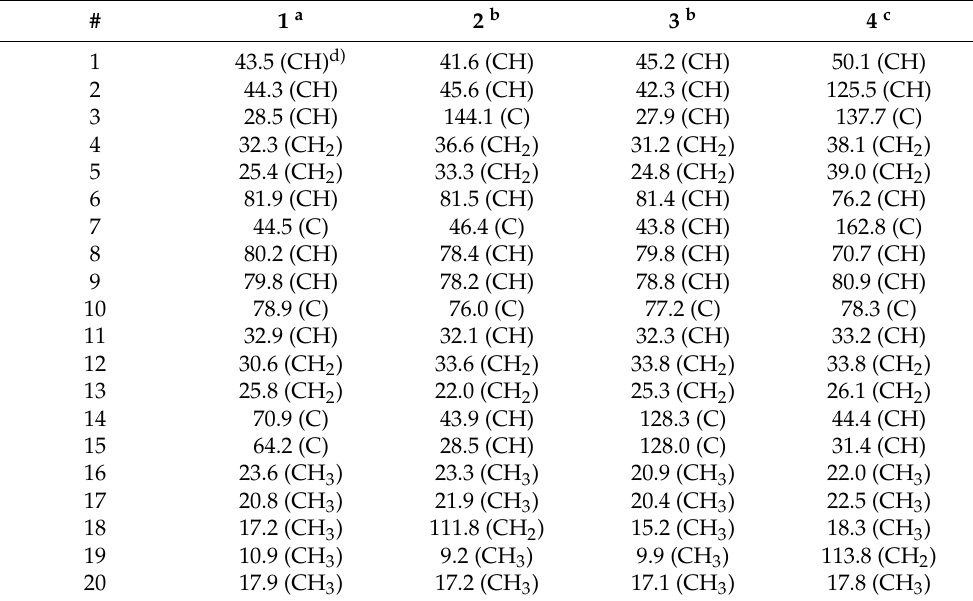
Figure 2. Key proton homonuclear correlation spectroscopy ( 1 H- 1 H COSY) and heteronuclear multiple bond correlation (HMBC) correlations for ( 1 – 4 ). Table 1. 13 C NMR spectroscopic data of compounds